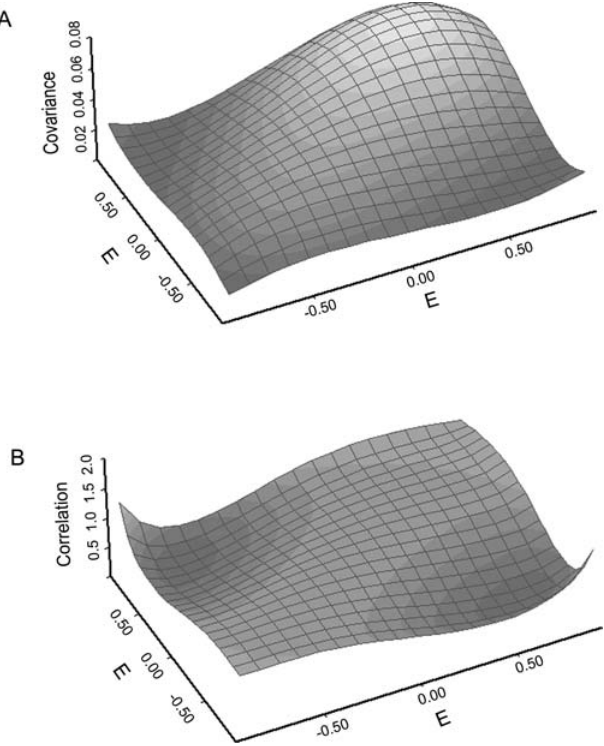
(Figure 4; Pearson’s correlation r ¼(cid:1) 0.512, df ¼ 17, p ¼ 0.025).